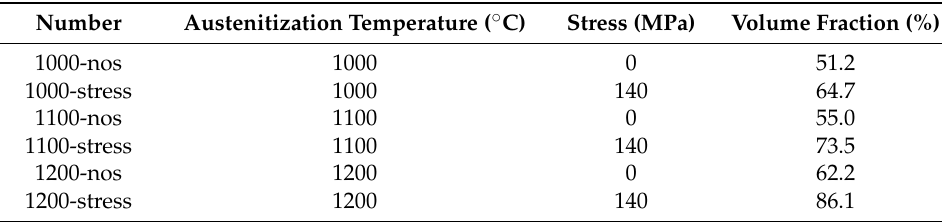
Table 2. Volume fraction of bainite in different samples.